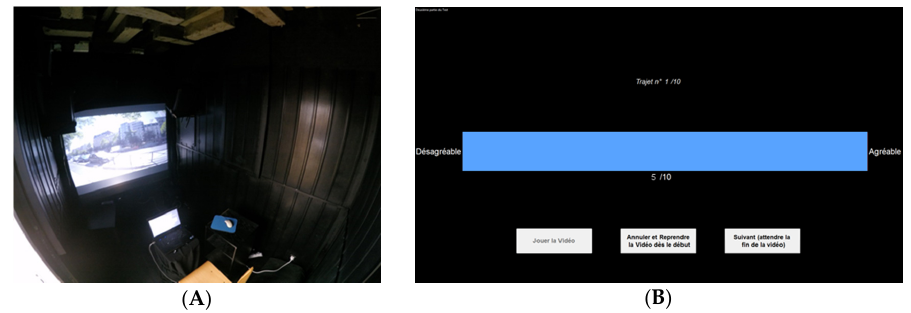
Figure 2. ( A ) Experimental setup and ( B ) graphical interface for continuous assessments.